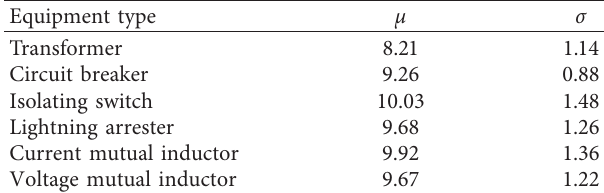
Table 2: Gaussian distribution accumulation function curve pa- rameter values of high-voltage electrical equipment damage rate.